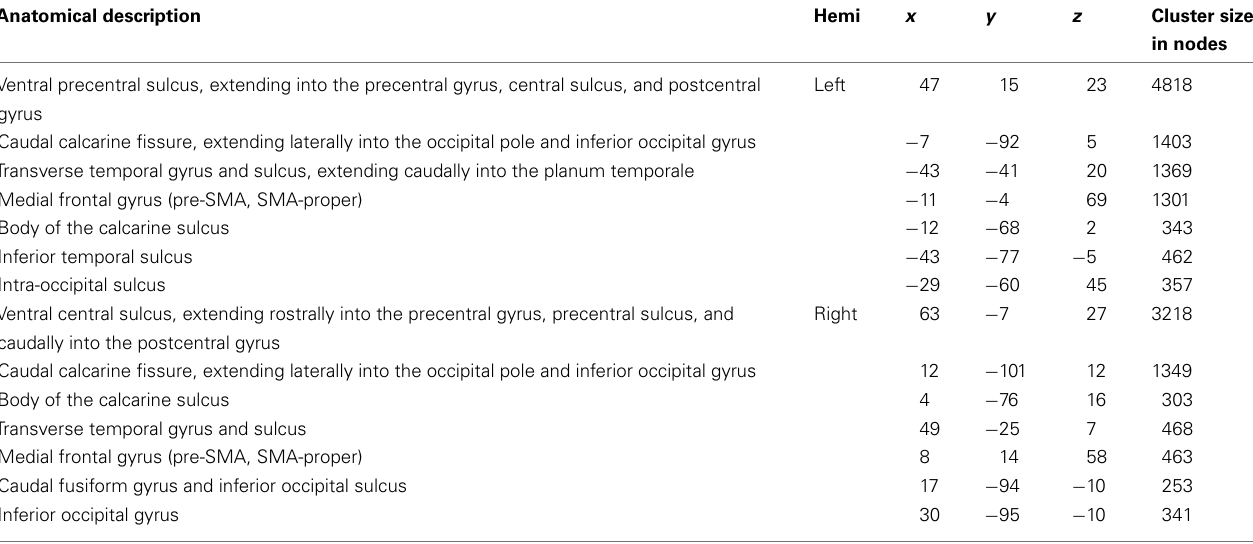
All coordinates are in Talairach space and represent the centroid surface node for each of the cluster (minimum cluster size: 168 contiguous surface nodes, each significant at p <